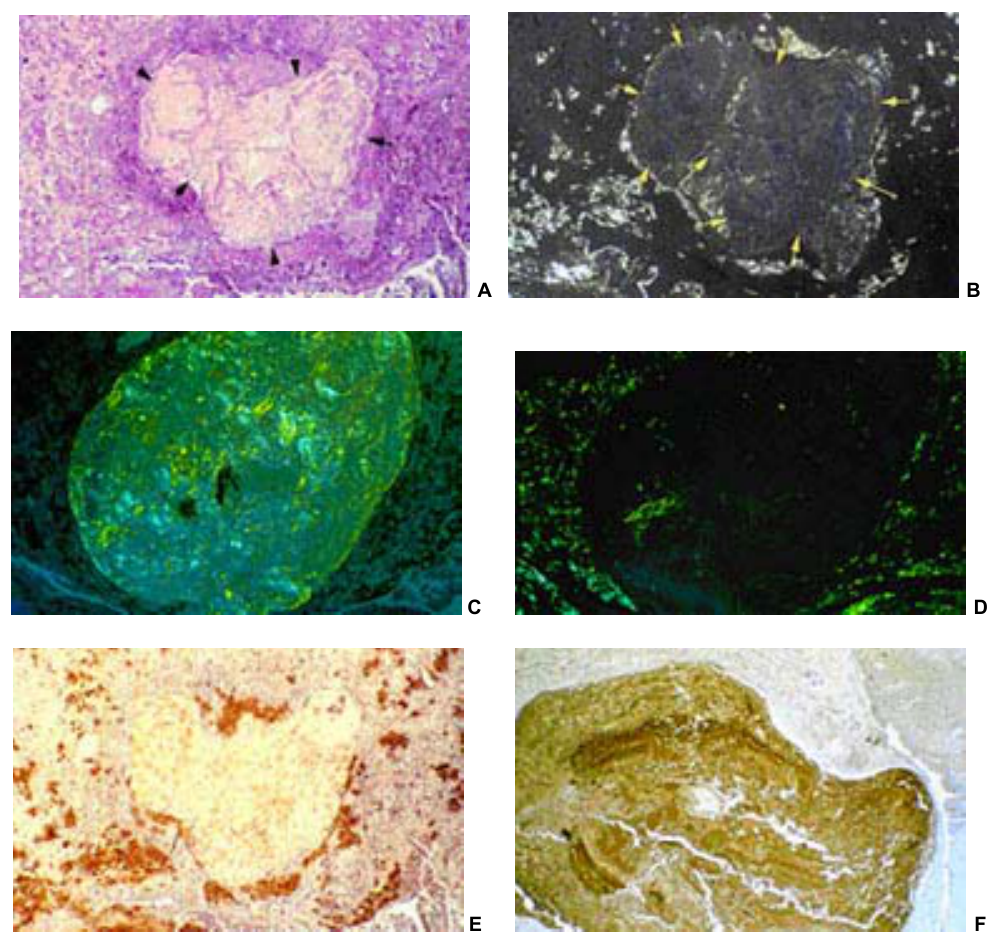
FIGURE 1A–F. Kidney. Systemic secondary AA amyloidosis and localized β 2-microglobulin amyloid (A β 2M) deposits. (A) Hematoxylin and Eosin. × 50. A β 2M containing cyst is marked with arrows. This cyst corresponds to Fig. 1C (in which the β 2-microglobulin amyloid deposits preserved the birefringence of typical green polarization color after performate pretreatment), and corresponds to Fig. 1F (in which the β 2- microglobulin amyloid was stained with antihuman β 2-microglobulin reaction). The rest of amyloid deposits in Fig. 1B are amyloid A (which have lost the birefringence of typical green polarization color after performate pretreatment in Fig. 1C; and preserved it after KMnO 4 oxidation in Fig. 1D; and was stained with antihuman amyloid A in Fig. 1E. (B) Same as Fig. 1A. Amyloid A and A β 2M deposits with typical green polarization color. Congo red staining according to Romhányi, without alcoholic differentiation, covered with gum arabic, viewed under polarized light. × 50. (C) Same as Fig. 1A. Amyloid A deposits are sensitive to performate pretreatment ( for 1 sec) , and A β 2M deposits localized to renal retention cyst are resistant ( for 1–20 sec) . × 50. (D) Same as Fig. 1A. Amyloid A is resistant to KMnO 4 oxidation (for 30 sec – 1 min) , and localized A β 2M deposits are sensitive to KMnO 4 oxidation ( for 30 sec). × 50. (E) Same as Fig. 1A. Amyloid A deposits are positive for antihuman amyloid A component 1:100 (monoclonal antibody MO759; DAKO, Glostrup, Denmark), Streptavidin-biotin complex/horseradish peroxidase reaction. × 50. (F) Localized A β 2M is positive for a-hu β 2-microglobulin 1:400 (polyclonal antibody